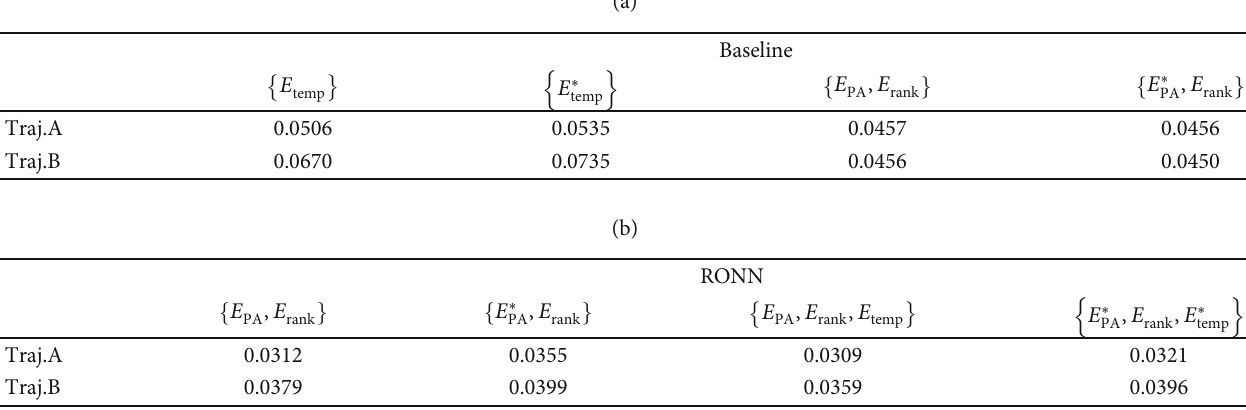
Table 3: e on improved loss functions. 3 D